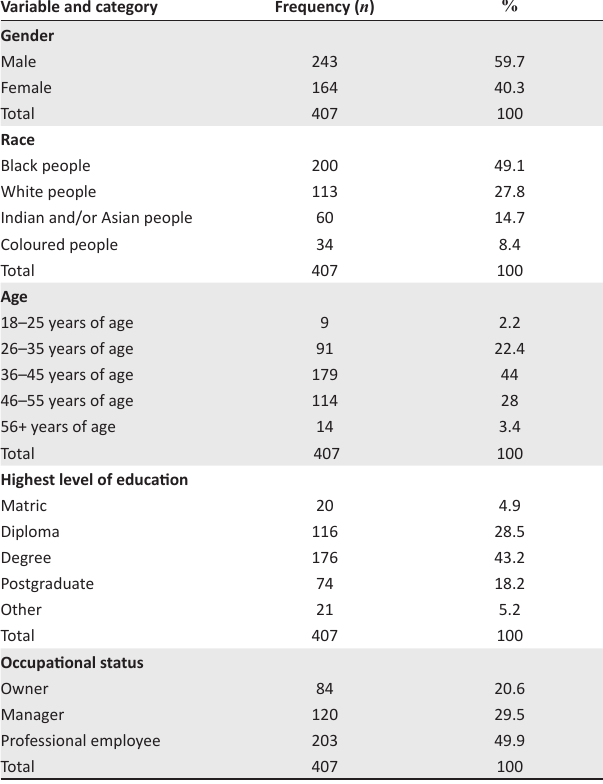
TABLE 1 : Demographic details of